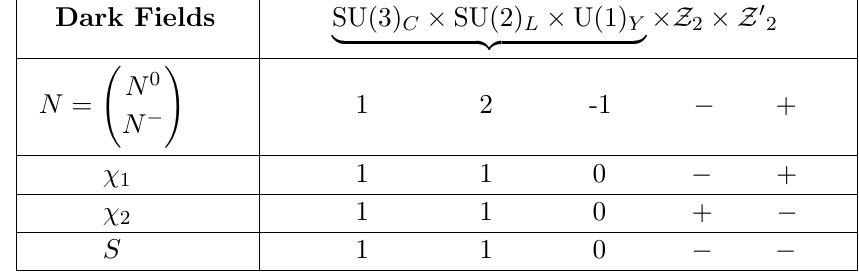
Table 1 . Dark sector (cid:12)elds and their corresponding quantum numbers under 0 SU(2) L U(1) Y 2 (cid:2) (cid:2) Z 2 (cid:2) Z